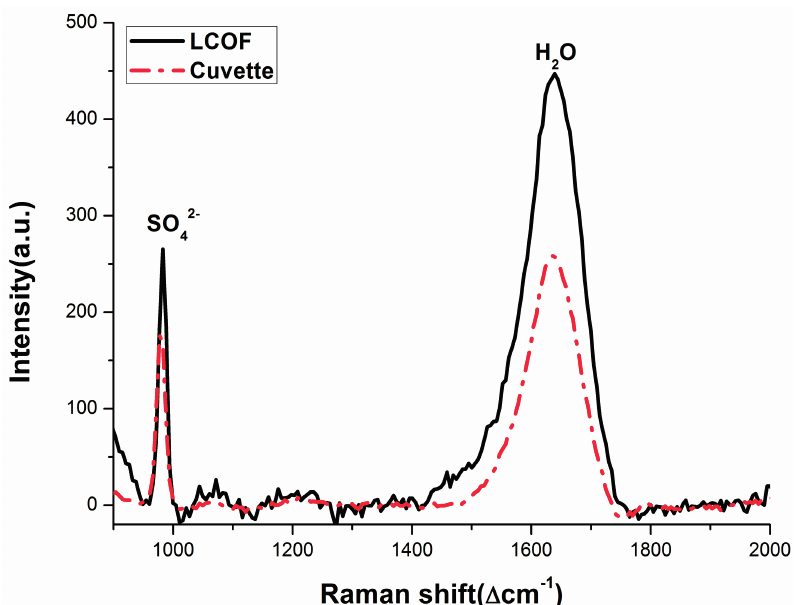
Figure 6. Raman spectra of 30 mmol/L sulfate solution using the LCOF-Raman experimental